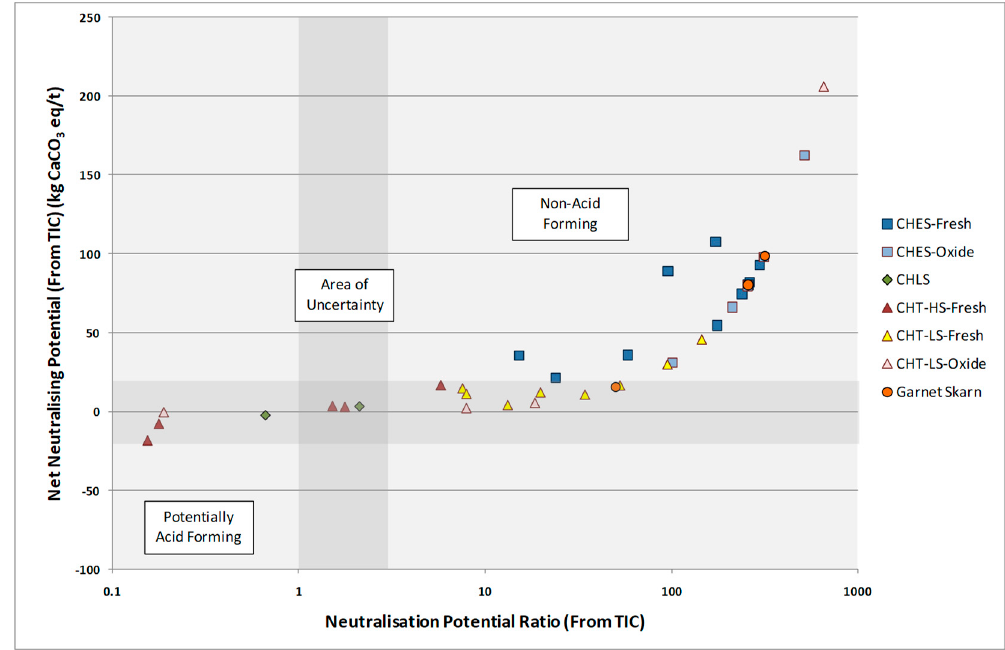
Figure 7. Scatter plot comparing NPR and NNP of the core samples. Both calculated from total inorganic carbon.